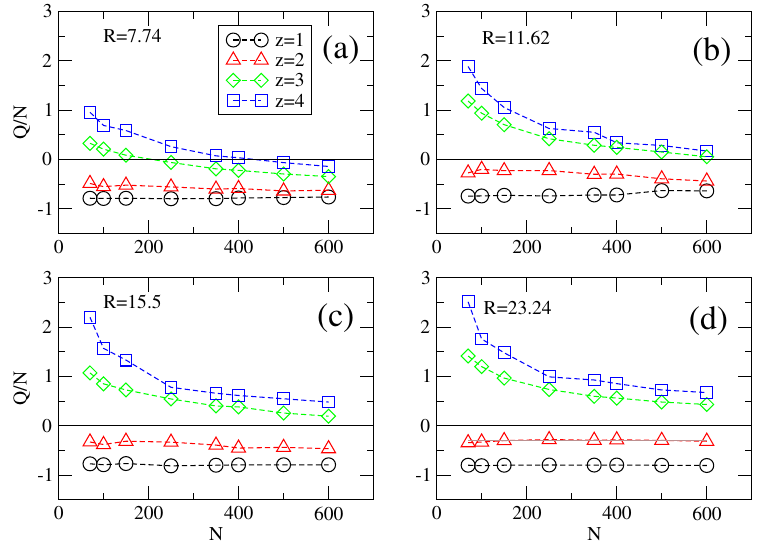
Figure 8. Effective charge Q per chain length N at zero field ( E function of the length N of the polyelectrolyte for ( a – d ) different radii R = 7 . 74 , 11 . 62 , 15 . 5 and 23 . 24 of the cylinder and valency z of the multivalent counterions. In the presence of tri-, or tetra-valent counterions the effective charge charges sign at some critical chain